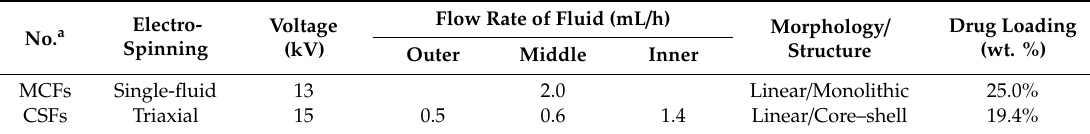
Table 1. Parameters of the monolithic composite nanofibers (MCFs) and core–shell structural nanofiber